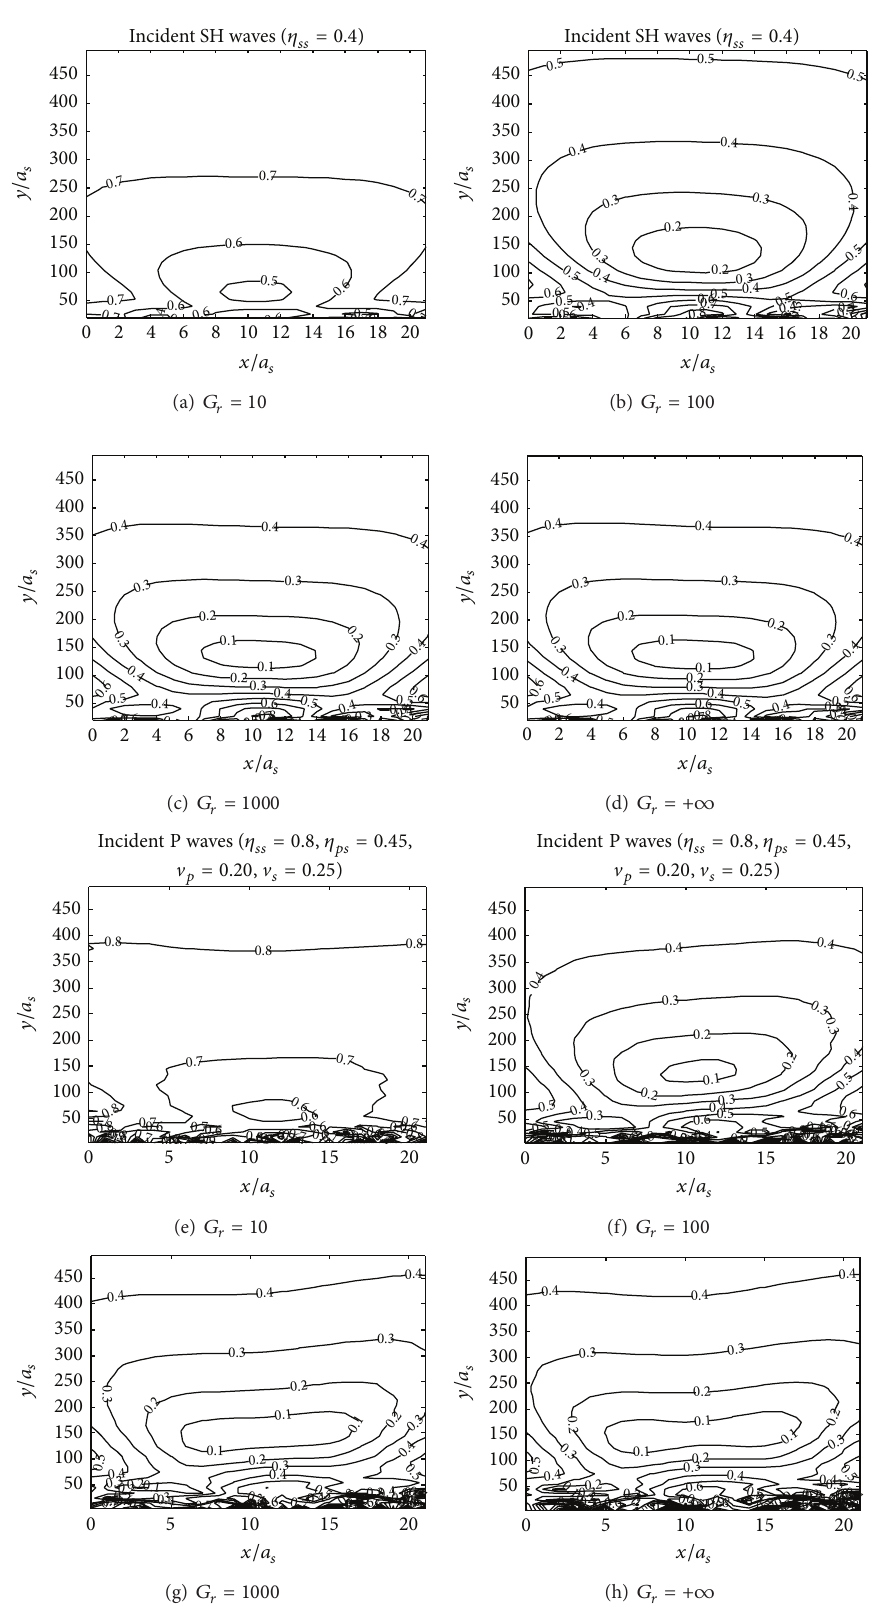
Figure 6: Contours of normalized displacement amplitudes by double-row tubular piles ( 𝑠 𝑝 = 3.0𝑎 𝑠 , ℎ = 3.0𝑎 𝑠 , 𝑏 𝑠 = 0.9𝑎 𝑠 , 𝑚 = 4 , 𝑁 = 8